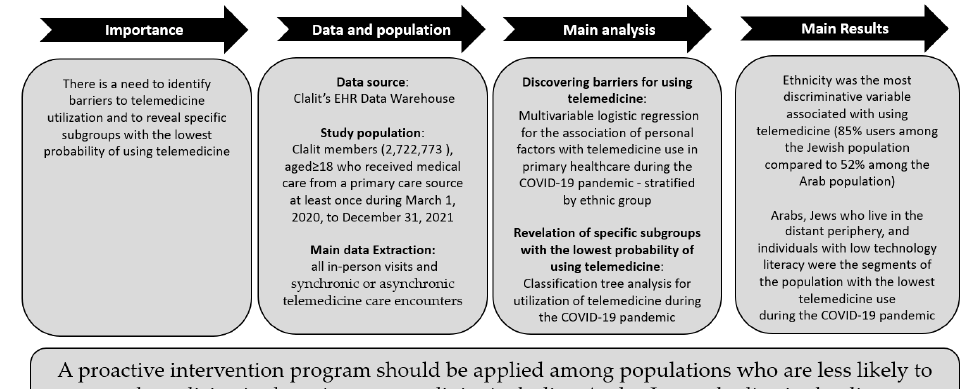
Figure 2. General research